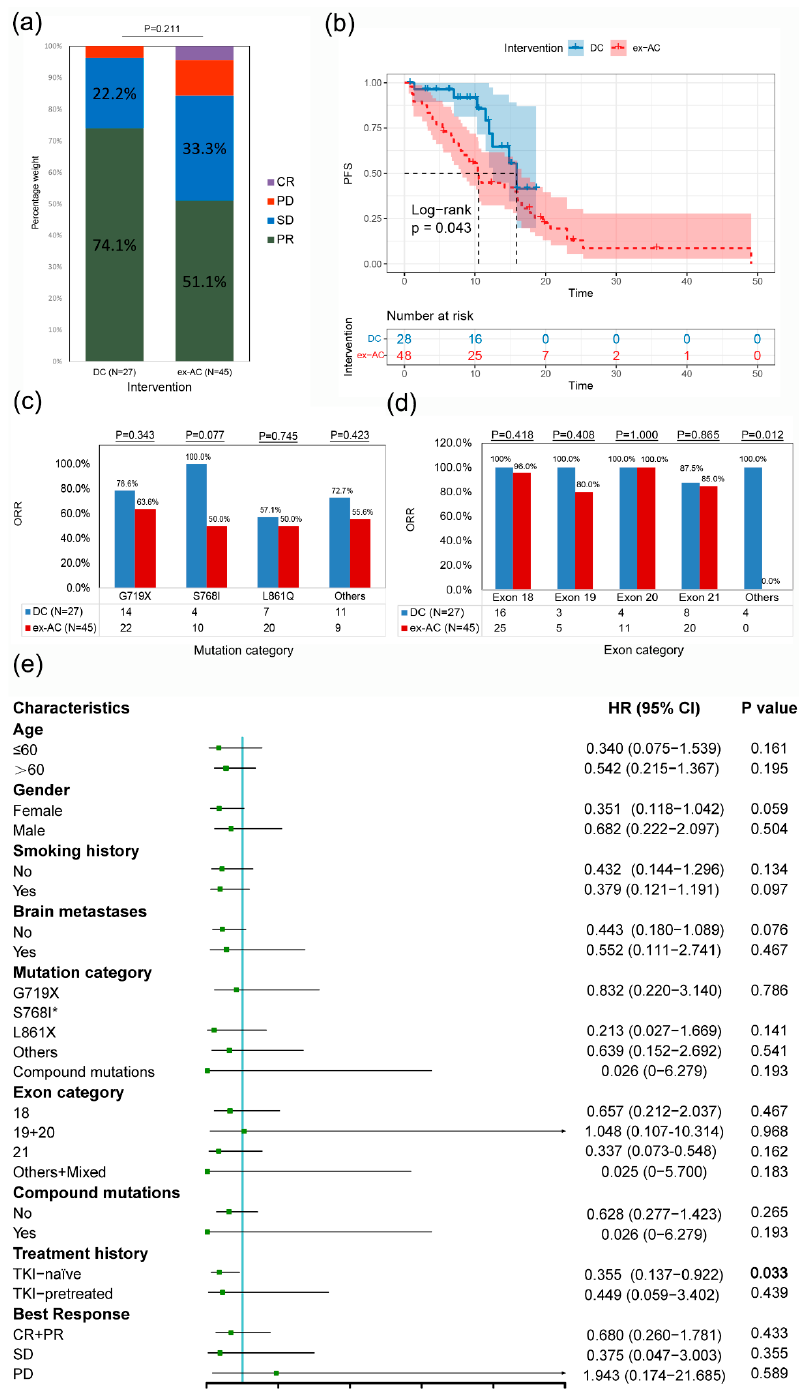
Figure 4. Comprehensive comparison between the DC and the ex-AC after PSM. Stacked histogram of treatment responses ( a ), Kaplan-Meier curves ( b ), ORRs of different mutation categories ( c ), ORRs of different exon categories ( d ), and subgroup analysis of PFS ( e ) of the DC and the ex-AC after PSM. ORR, objective response rate; PFS, progression-free survival; DC, dacomitinib cohort; AC, afatinib cohort; ex-AC, external afatinib cohort; CR, complete response; PR, partial response; SD, stable disease; PD, progressive disease; HR, hazard ratio; CI, confidence interval; TKI, tyrosine kinase inhibitor; PSM, propensity score matching. * Uncommon mutation categories overlap with compound mutations, so each patient might belong to more than one group. Since there were no cases with others in the ex-AC, the forest plot was not